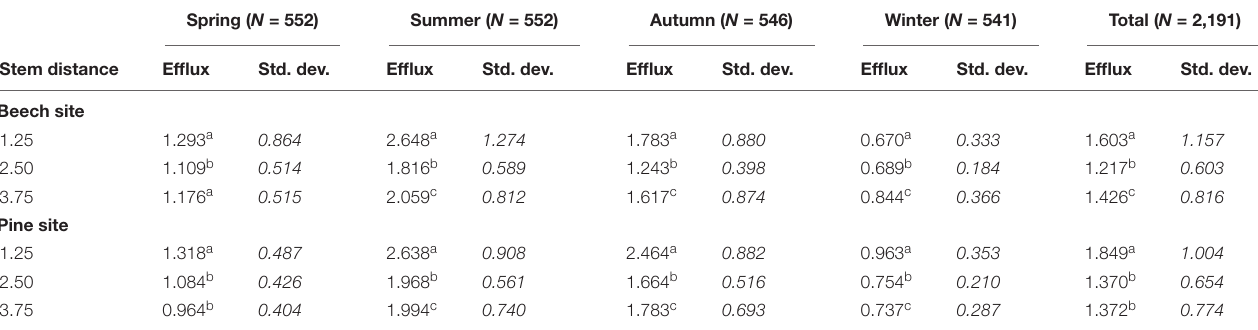
Different letters indicate significant differences in the CO 2 efflux between the stem distances according to Friedman’s test (p < 0.05).